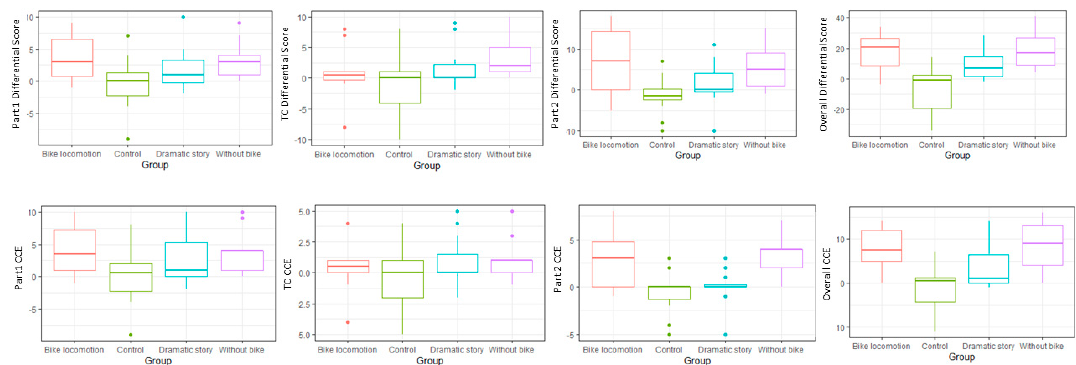
Figure 3. Di ff erences in the group e ff ect of the self-regulation (upper part of the panel) and cognitive control estimation for each part of the HTKS